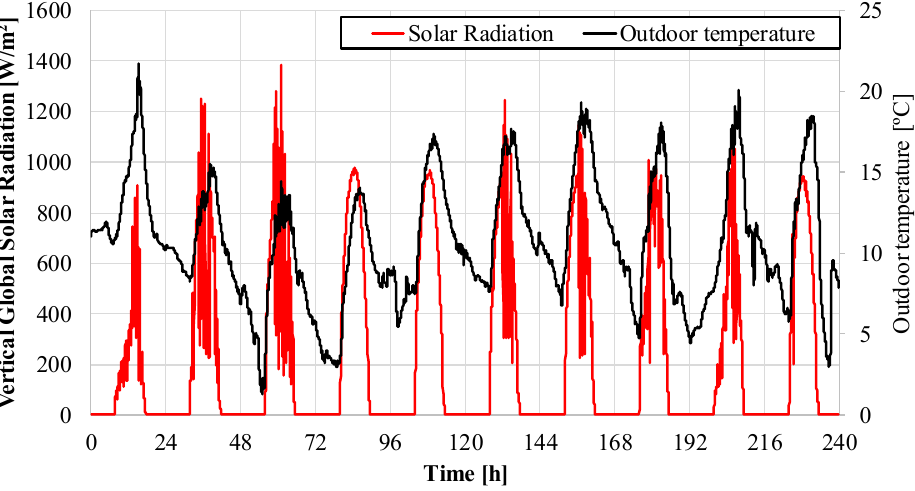
Figure 3. Weather conditions during the analyzed period.